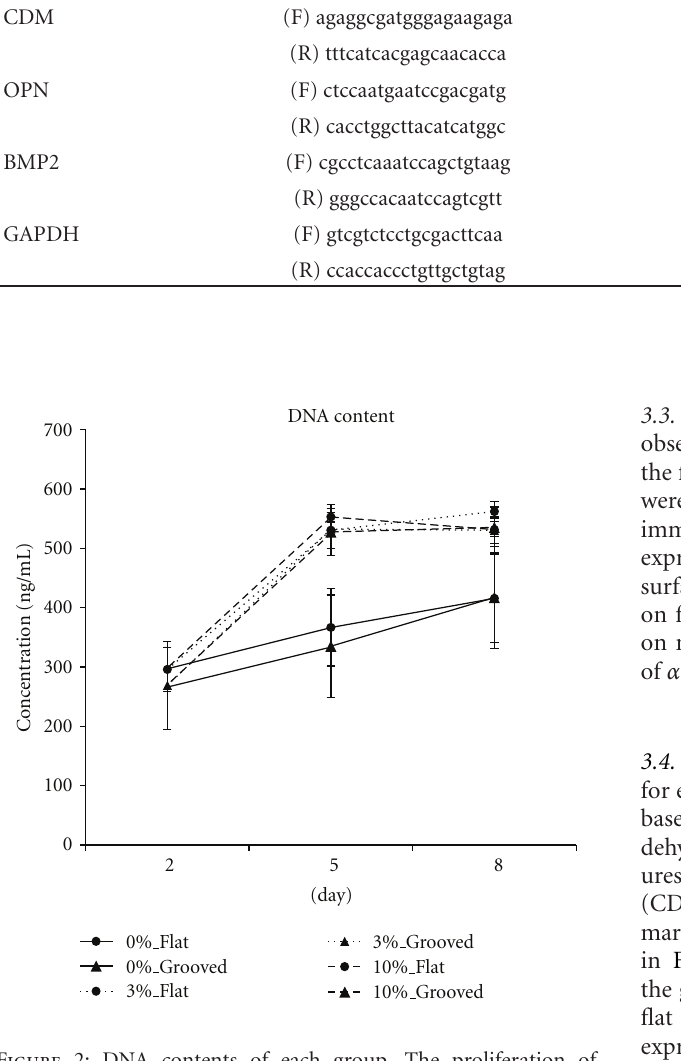
Figure 2: DNA contents of each group. The proliferation of strained MSCs was increased compared to that of unstrained MSCs regardless of the magnitudes of the stimuli or microgrooves. Mechanical stimuli were applied to MSCs for 3 days from 48h after seeding (Day 2). Days 5 and 8 refer to the time points immediately after stimuli ceased and 3 days after stimuli ceased, respectively. ( n =